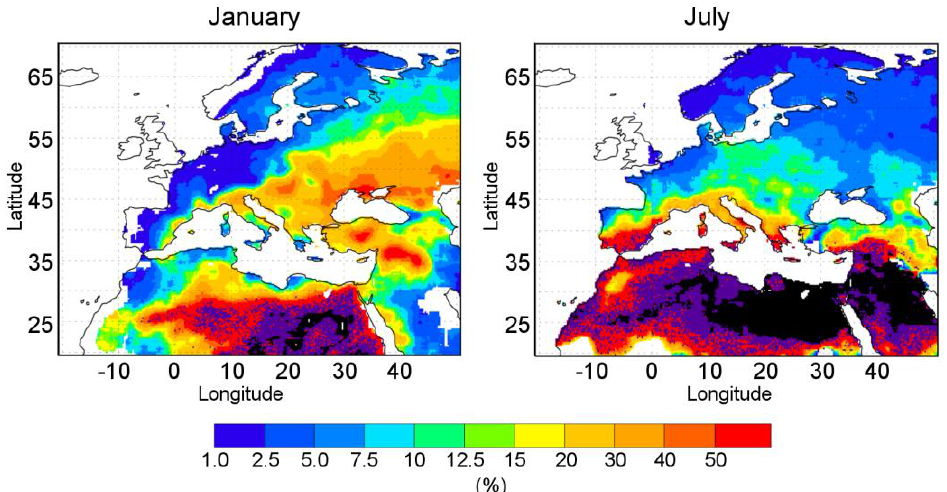
Figure 9. Similar to Figure 8 but comparing the percentage between PFLEX-extreme and MSWEP-extreme during January (right panel) and July (left panel). White areas over the continent indicate where the PFLEX-Cli does not report values. Violet represents percentage values of 100% and the black color indicates those regions where the MSWEP precipitation dataset does not show values.